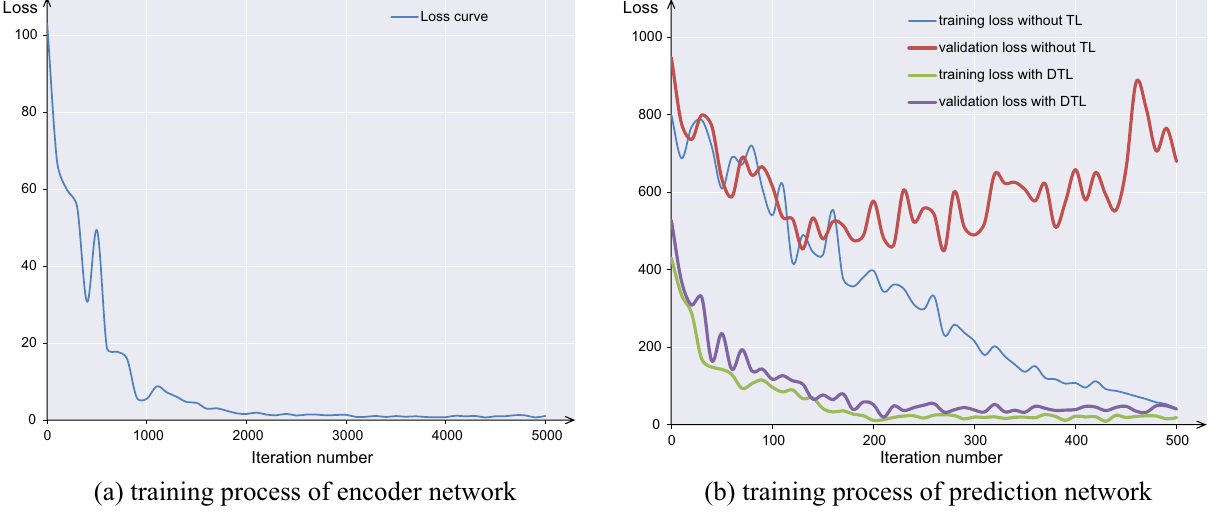
Figure 2. The loss curve during training